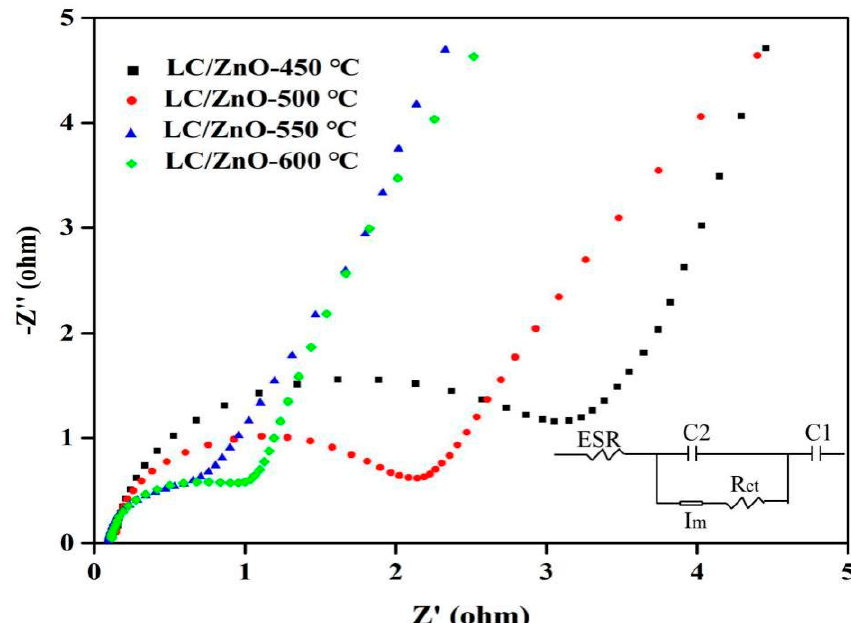
Figure 8. Nyquist plot and fitted equivalent circuit diagrams (inset) of LC/ZnO composites at different temperatures (C1 refers to the external power supply. C2 refers to the three-electrode system. Rct refers to the charge transfer resistance of the interface between the LC/ZnO electrode material and the electrolyte. ESR refers to the the equivalent series resistance of the composite material. Im is equivalent to a galvanometer).